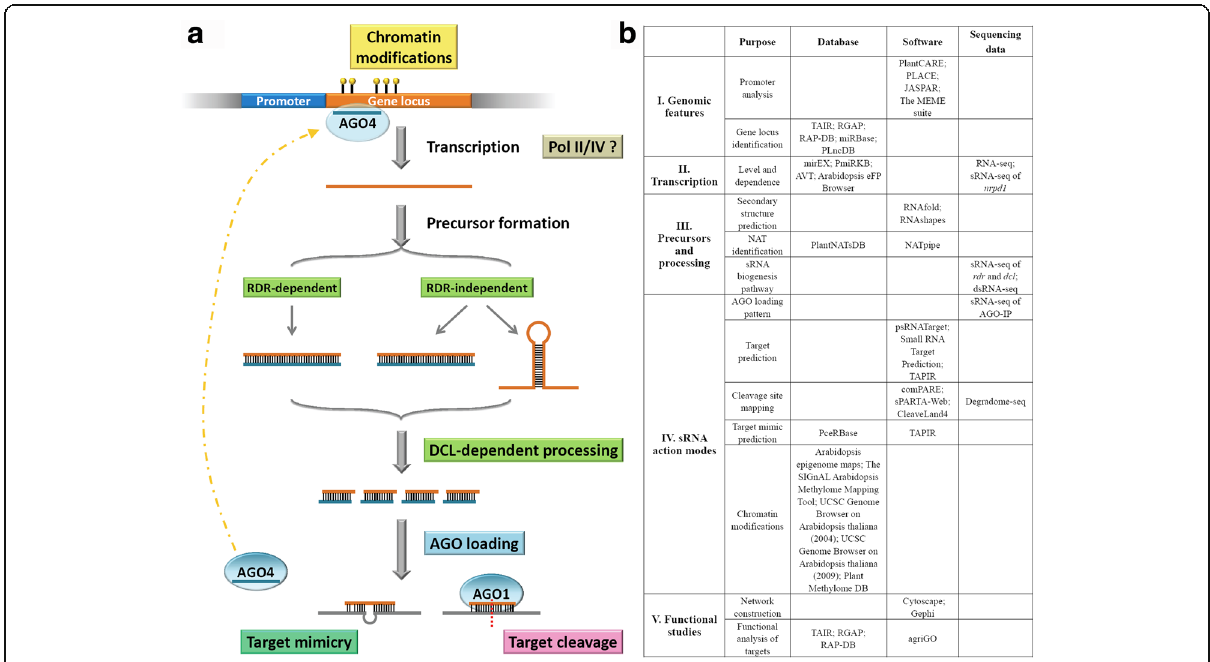
Fig. 1 A general workflow for public bioinformatics resource-based investigation of small RNA (sRNA) biogenesis and action pathways in plants. a Presents a brief framework of the biogenesis and action pathways of plant sRNAs. AGO: Argonaute; Pol: RNA polymerase; RDR: RNA-dependent RNA polymerase; DCL: Dicer-like; sRNA: small RNA. b The analysis is divided into five sections according to the step-by-step instructions in the main text, including “ genomic features ” , “ transcription ” , “ precursors and processing ” , “ sRNA action modes ” and “ functional studies